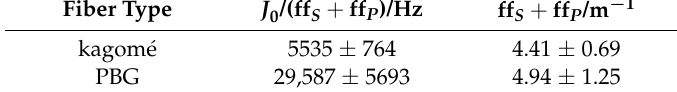
Table 4. Fit parameters for both types of fibers as well as the offset value for 0 m fiber